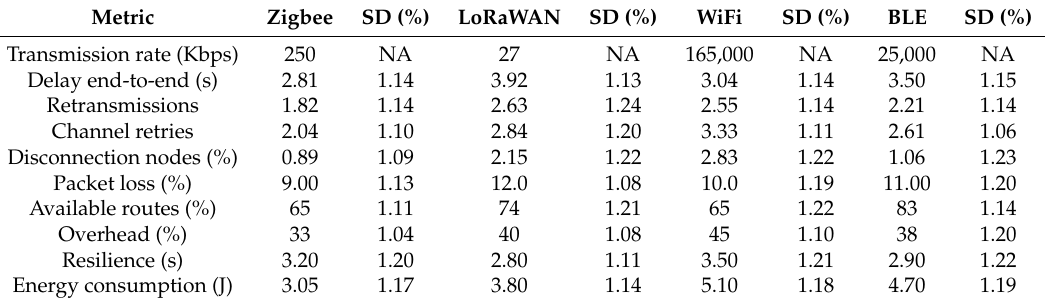
Table 3. Nodes under the collaborative